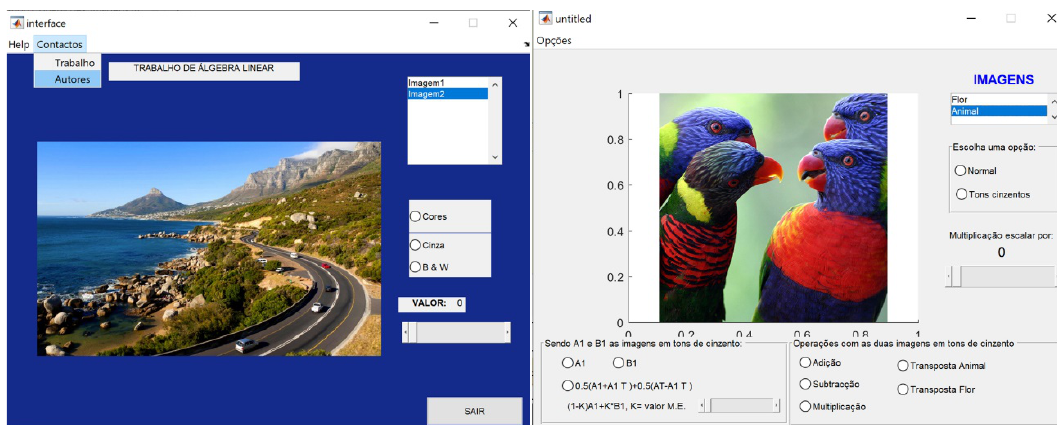
Figure 5. Graphical interfaces developed in Matlab